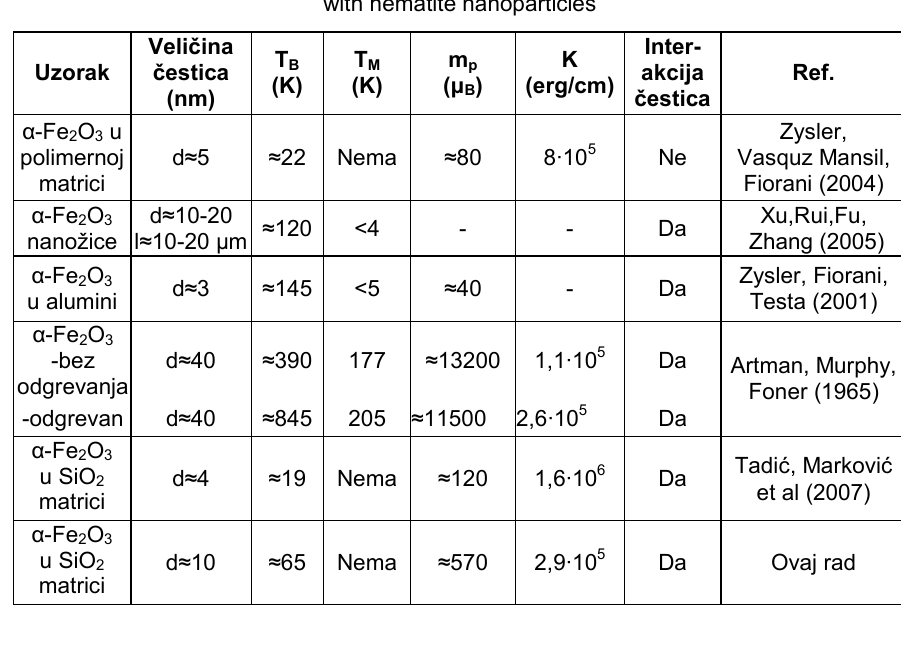
Table 1 – Review of magnetic properties for some nanoparticle systems with hematite